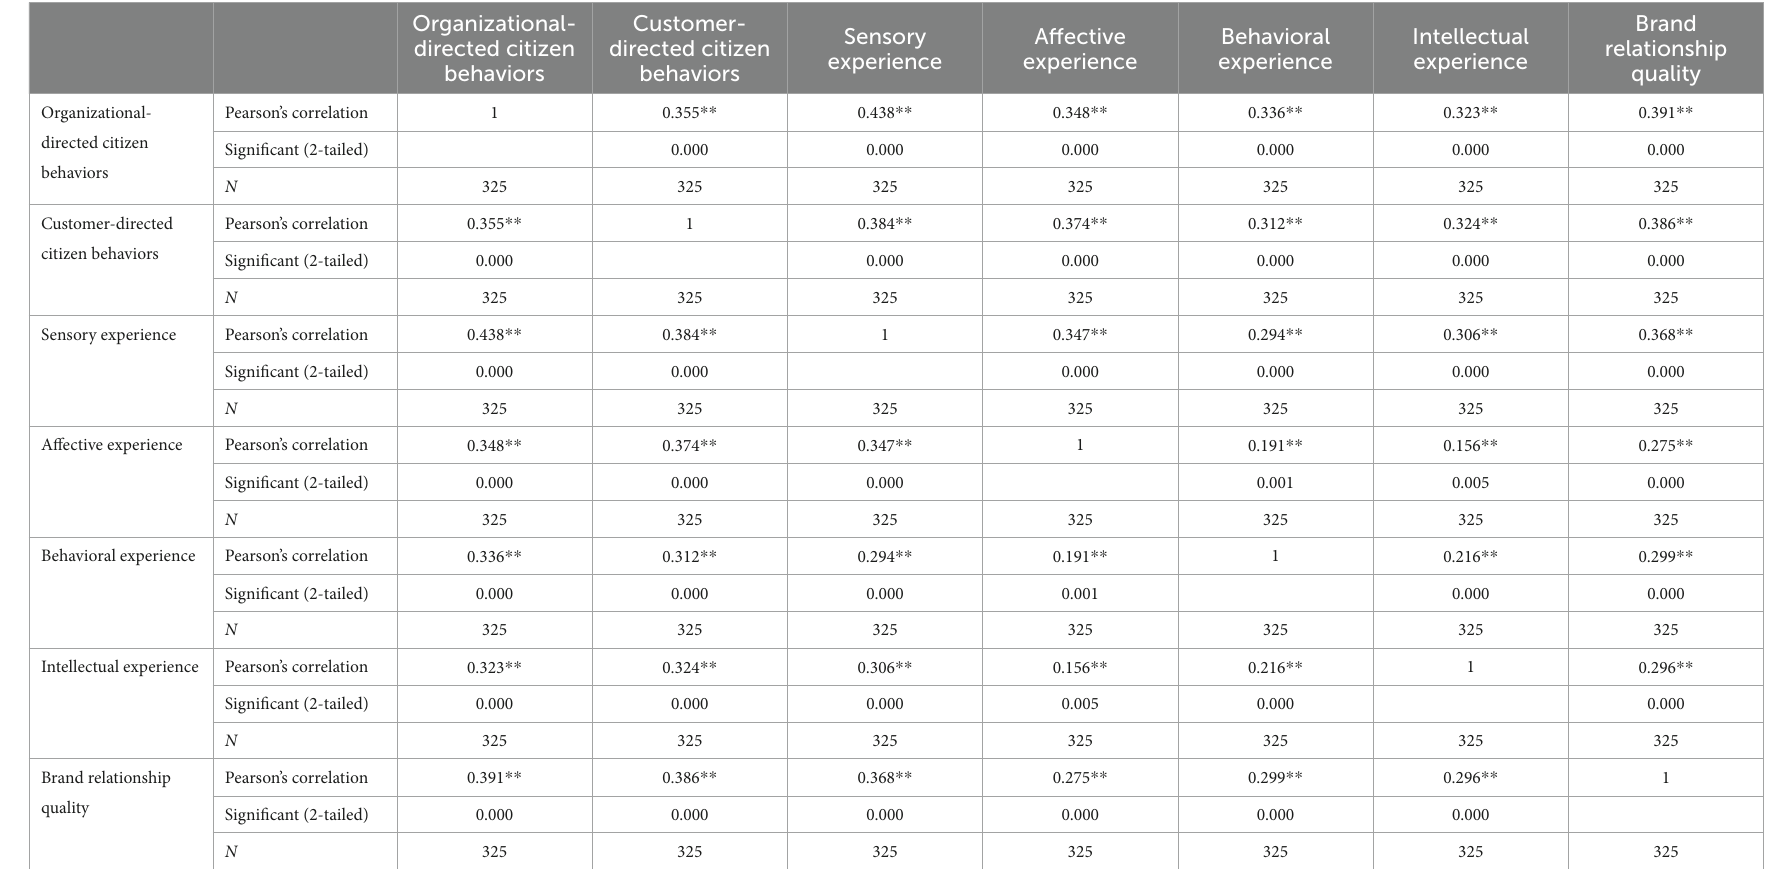
TABLE 6 Variable correlation analysis.